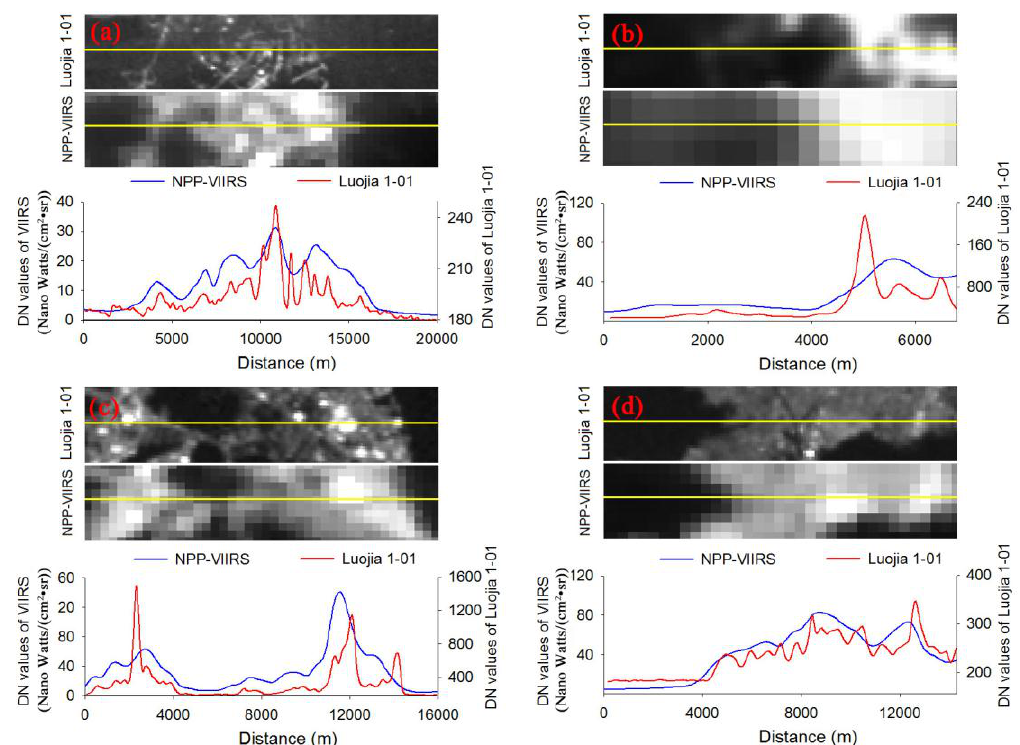
Figure 5. Latitudinal transects of the nighttime light DN between LuoJia1-01 and Suomi National Polar-Orbiting Partnership Visible Infrared Imaging Radiometer Suite (NPP-VIIRS): ( a ) refers to Wuhan; ( b ) refers to Hangzhou; ( c ) refers to Seoul; ( d ) refers to Mexico City.